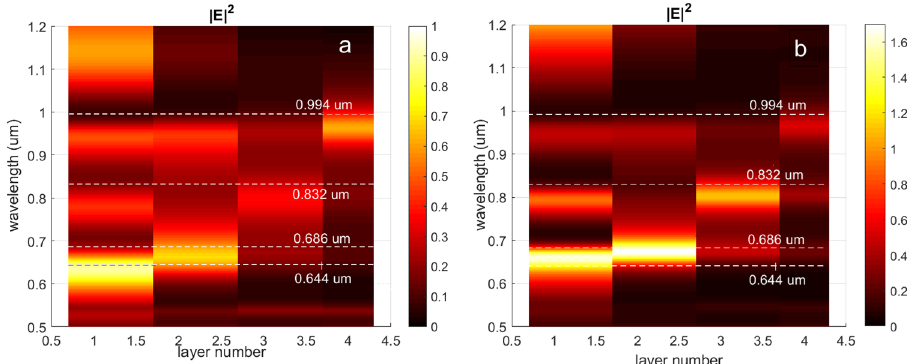
Figure 2. A spectral distribution of the mean |E| 2 in TiO 2 layers with ( a ) the smooth 3 nm-thick and ( b ) the patterned 9 nm-thick GdFeCo layers inside. Dashed lines indicate the operating wavelengths.